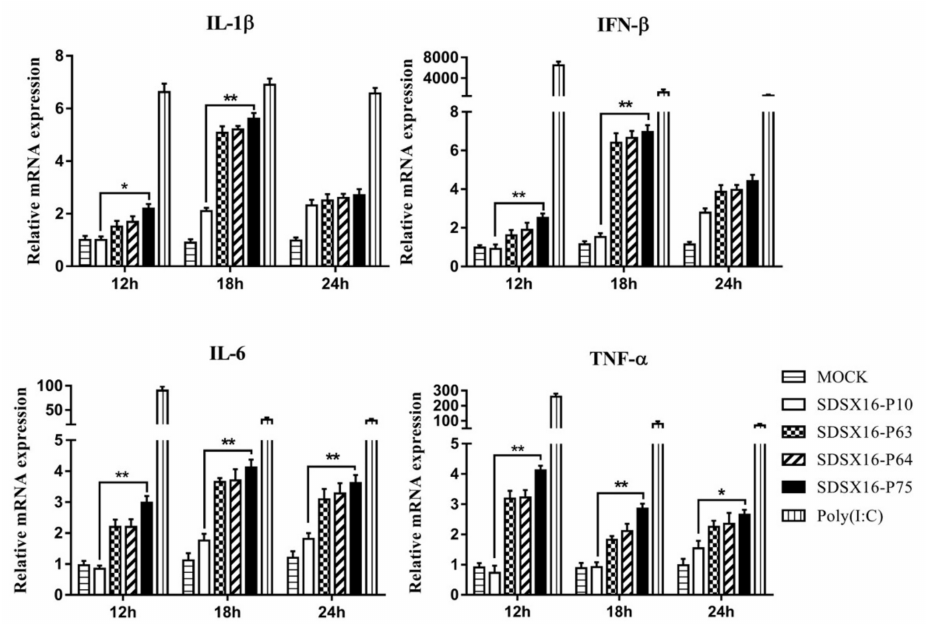
Figure 7. Expression of type I interferon and proinflammatory cytokines mRNA levels in porcine intestinal epithelial cells induced by di ff erent passage SDSX16 strains. The cells infected with PEDV SDSX16-P10, -P63, -P64, -P75 at an MOI of 1, MMT (Mock) or transfected with poly(I:C) were collected at 12, 18, 24 h post-infection (hpi). Relative IL1 β , IL6, TNF- α , and IFN- β mRNA expression was determined by qPCR. The data are shown as fold changes and were normalized to control cell data. The significant di ff erence between PEDV SDSX16-P10 and -P75 was expressed with their p values. The mean ± SEM of data from three independent experiments are shown. (* p < 0.05, ** p < 0.01). Next, we used flow cytometry to detect IL6 and TNF- α protein levels in cells infected with SDSX16-P10 or -P75. The results showed that SDSX16-P10 strain-stimulated IL6 and TNF- α expression of the protein was markedly lower than SDSX16-P75 at 18 hpi (Figure 8). Collectively, these data suggest that there was no significant di ff erence in cytokines expression between cells infected with SDSX16-P63 and -P64, and SDSX16-P10 had a stronger ability to inhibit cytokines expression than SDSX16-P75.